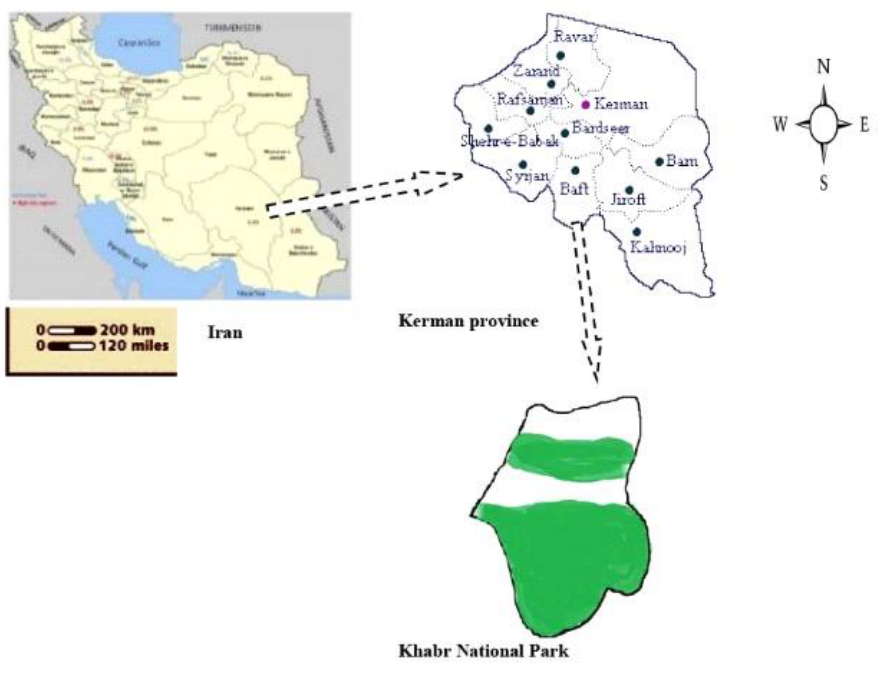
Fig. 1: Location of Khabr national Park on Iran